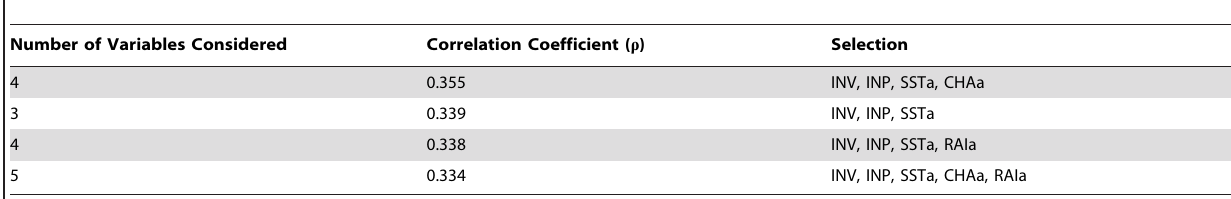
Abbreviations as in Table 2.